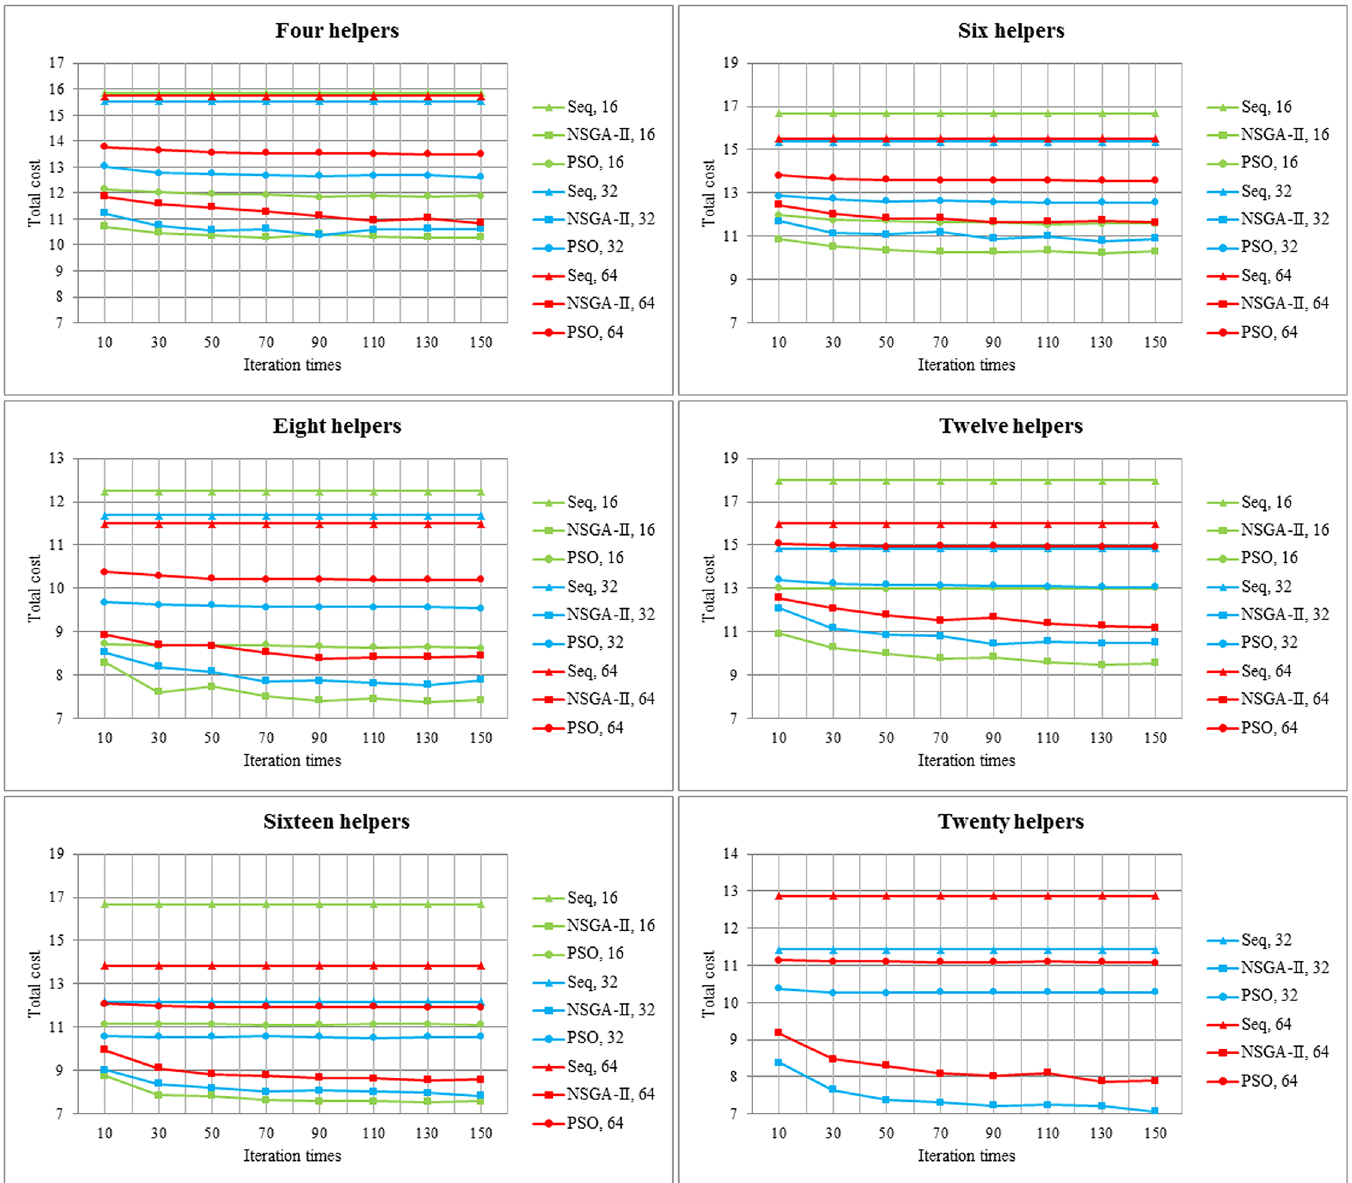
Fig 6. Total requester cost with a varying number of helpers and tasks. The x-axis and y-axis represent iteration times and the total cost, respectively. Every line graph reveals a number of helpers. We use triangle, square, and circle to denote sequential scheduling, NSGA-II and PSO, respectively. Green, blue and red show different task numbers